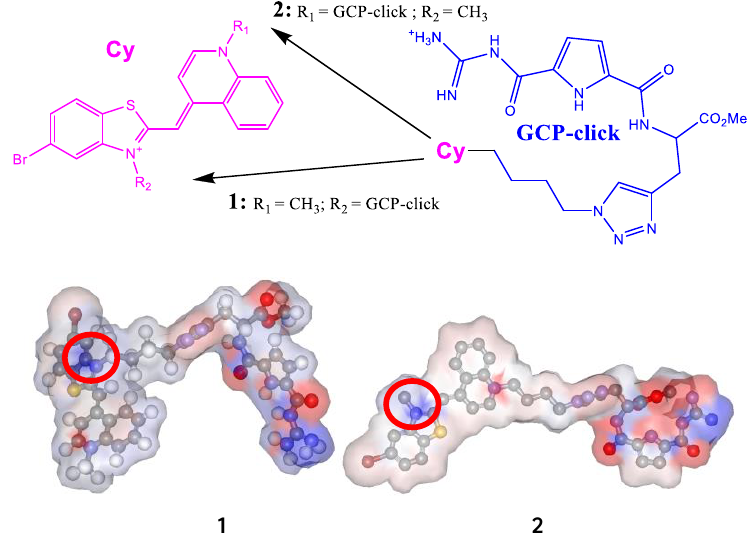
Scheme 1. TOP: General structure of studied compounds 1 and 2 ; DOWN: ball-and-stick models with superimposed van der Waals (VdW) radius surface denoting atom charge distribution (red-negative; blue positive), stressing the difference in the exposure of positive charge (red circles).